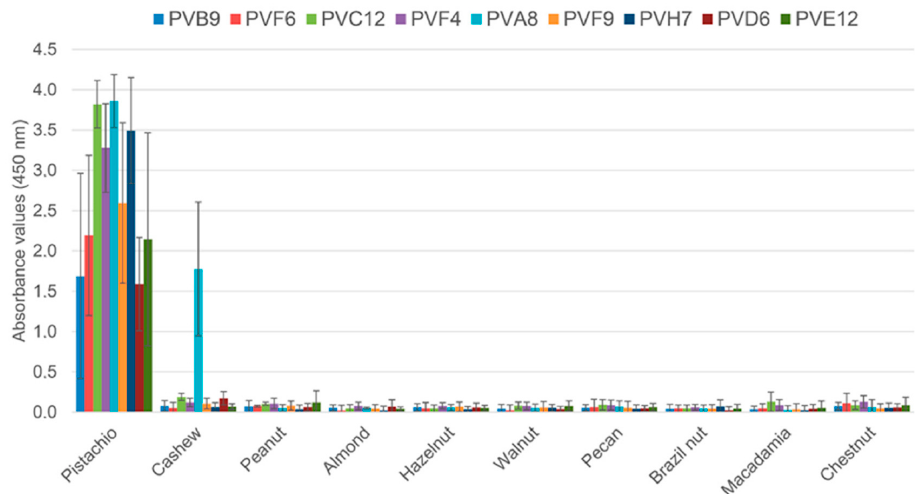
Figure 3. Indirect phage-dAb ELISA results obtained with monoclonal phages selected from the second round of biopanning against a set of tree nuts. Absorbance values are the mean of four independent experiments with duplicates. Error bars show the standard deviation for each set of data.